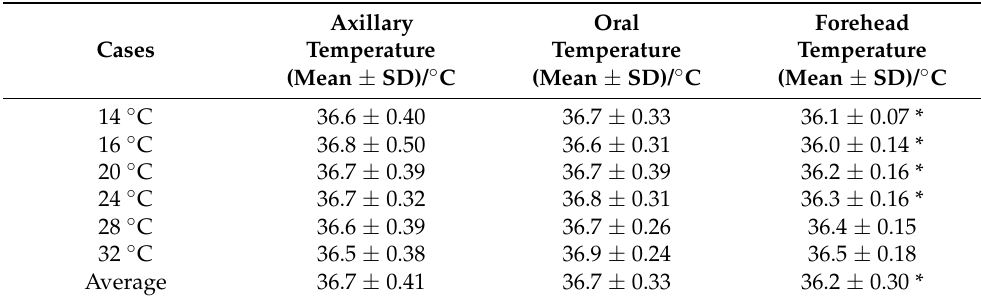
Table 1. Body temperature measurement results with the different measurement methods under different temperature conditions.